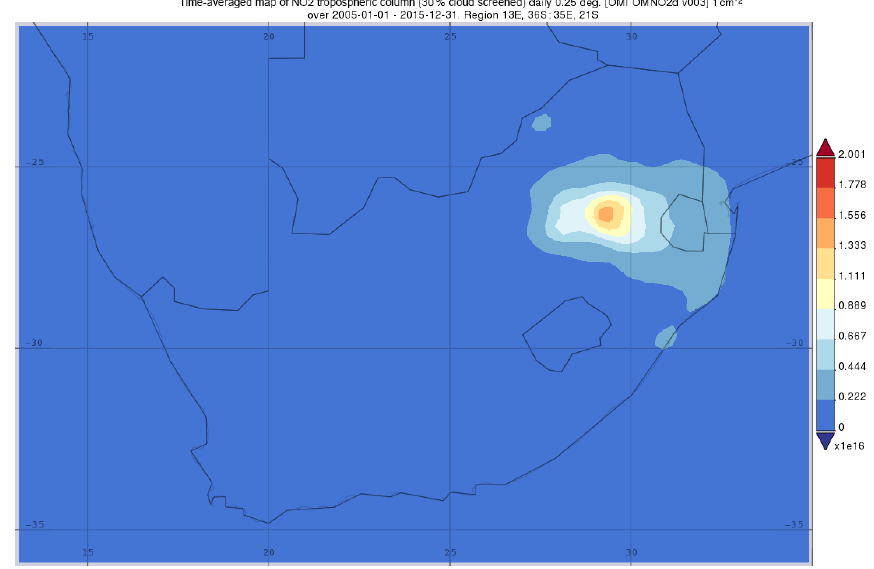
Figure A6. Geospatial map of southern Africa depicting the NO 2 tropospheric column density averaged over the period 2005 to 2015 ob- tained using the data from the NASA Giovanni satellite (https://giovanni.gsfc.nasa.gov/giovanni/). OMI: Aura Ozone Monitoring Instrument. OMSO2e v003: OMI Level-3e SO 2 Data Product. DU: Dobson